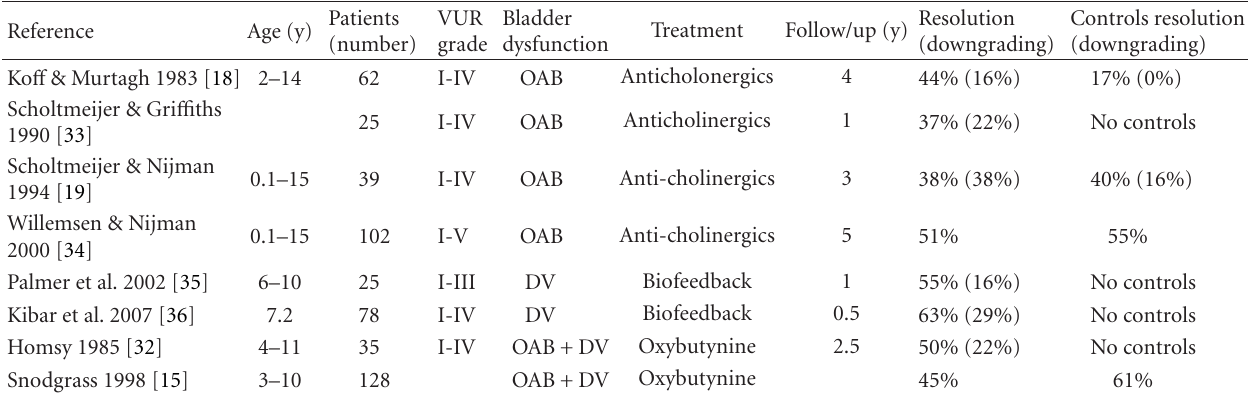
Table 3: Impact of treatment of bladder dysfunction on spontaneous resolution of